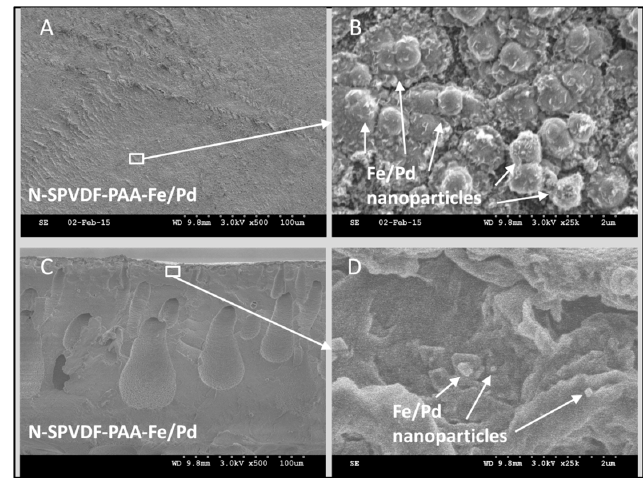
Figure 4. SEM images of N-SPVDF-PAA membrane functionalized with Fe/Pd nanoparticles ranging in size from 0.5 to 3.0 µm. Membrane top surface ( A , B ) and cross section ( C , D ).